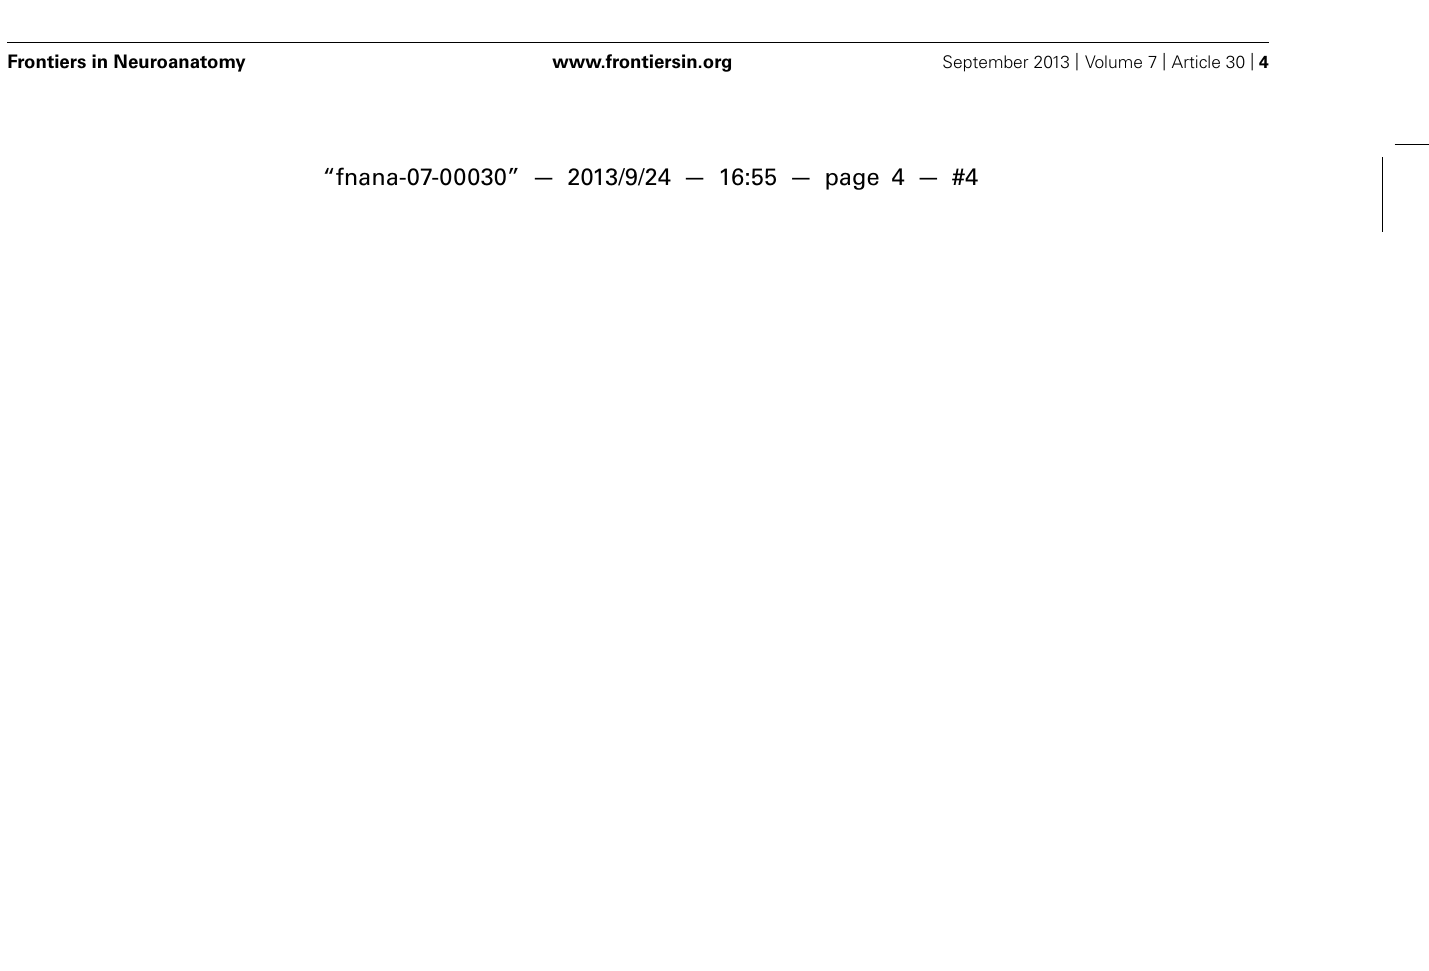
FIGURE 3 | Double-immunofluorescence labeling of representative thioflavin-S plaques and NF + neurites from preclinical AD (A,B), end-stage AD (D,E), APP/PS1 (G,H), andTg2576 (J,K) transgenic mice shows classical bulb-like swellings containing neurofilaments indicated by filled arrowheads in the plaque-core, small arrows at the plaque